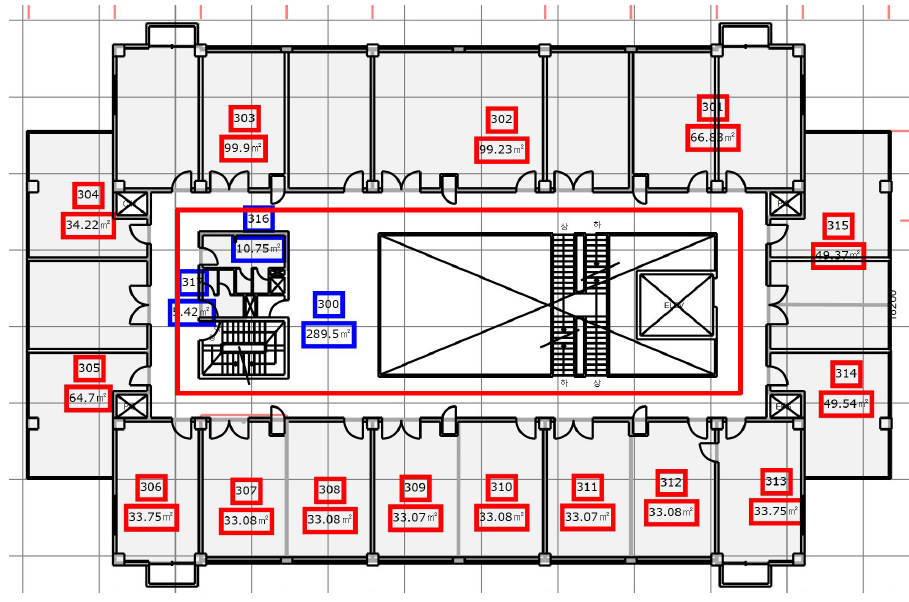
Figure 14. The test path on IACT building Floor